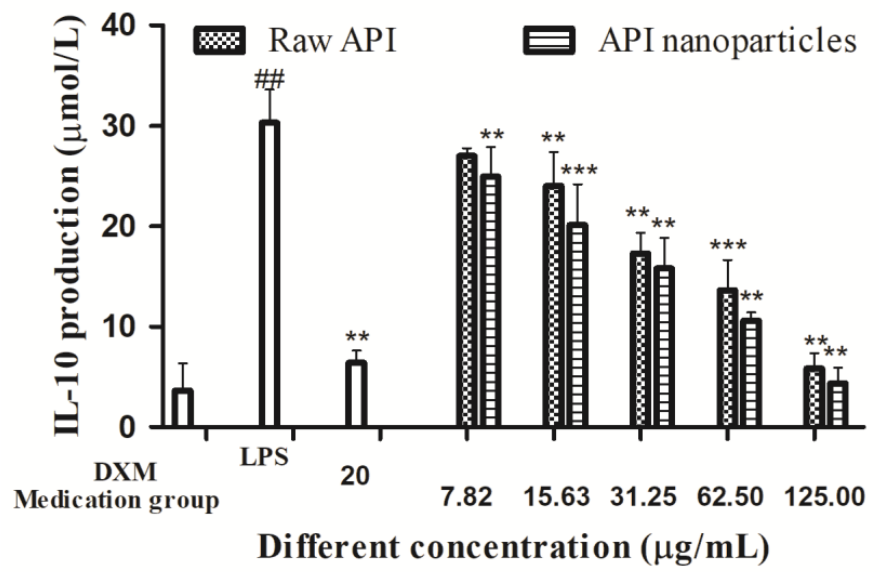
Figure 12. Effects of API nanoparticles on the IL-10 production of LPS-induced RAW264.7 cells ( ## p < 0.05 vs. the control group and ** p < 0.05, *** p < 0.01 vs. the LPS group).